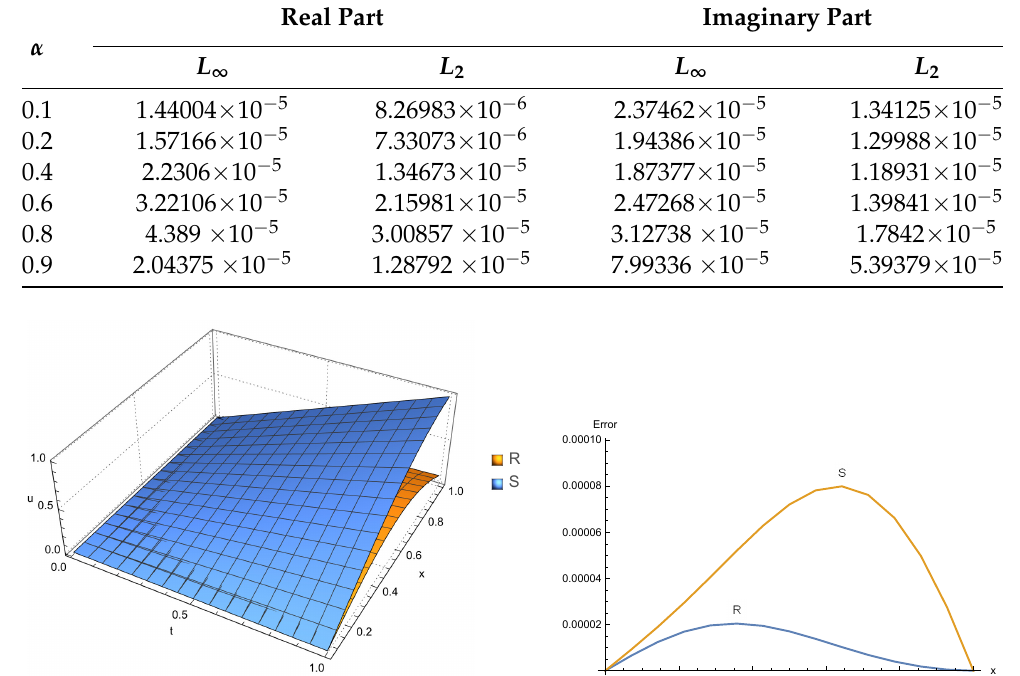
Figure 9. Computed approximation solutions and the error curves of R and S in Equation (4) for α = 0.9, τ = 1/512, a = 0, b = 1, N = 15 and t = 1.